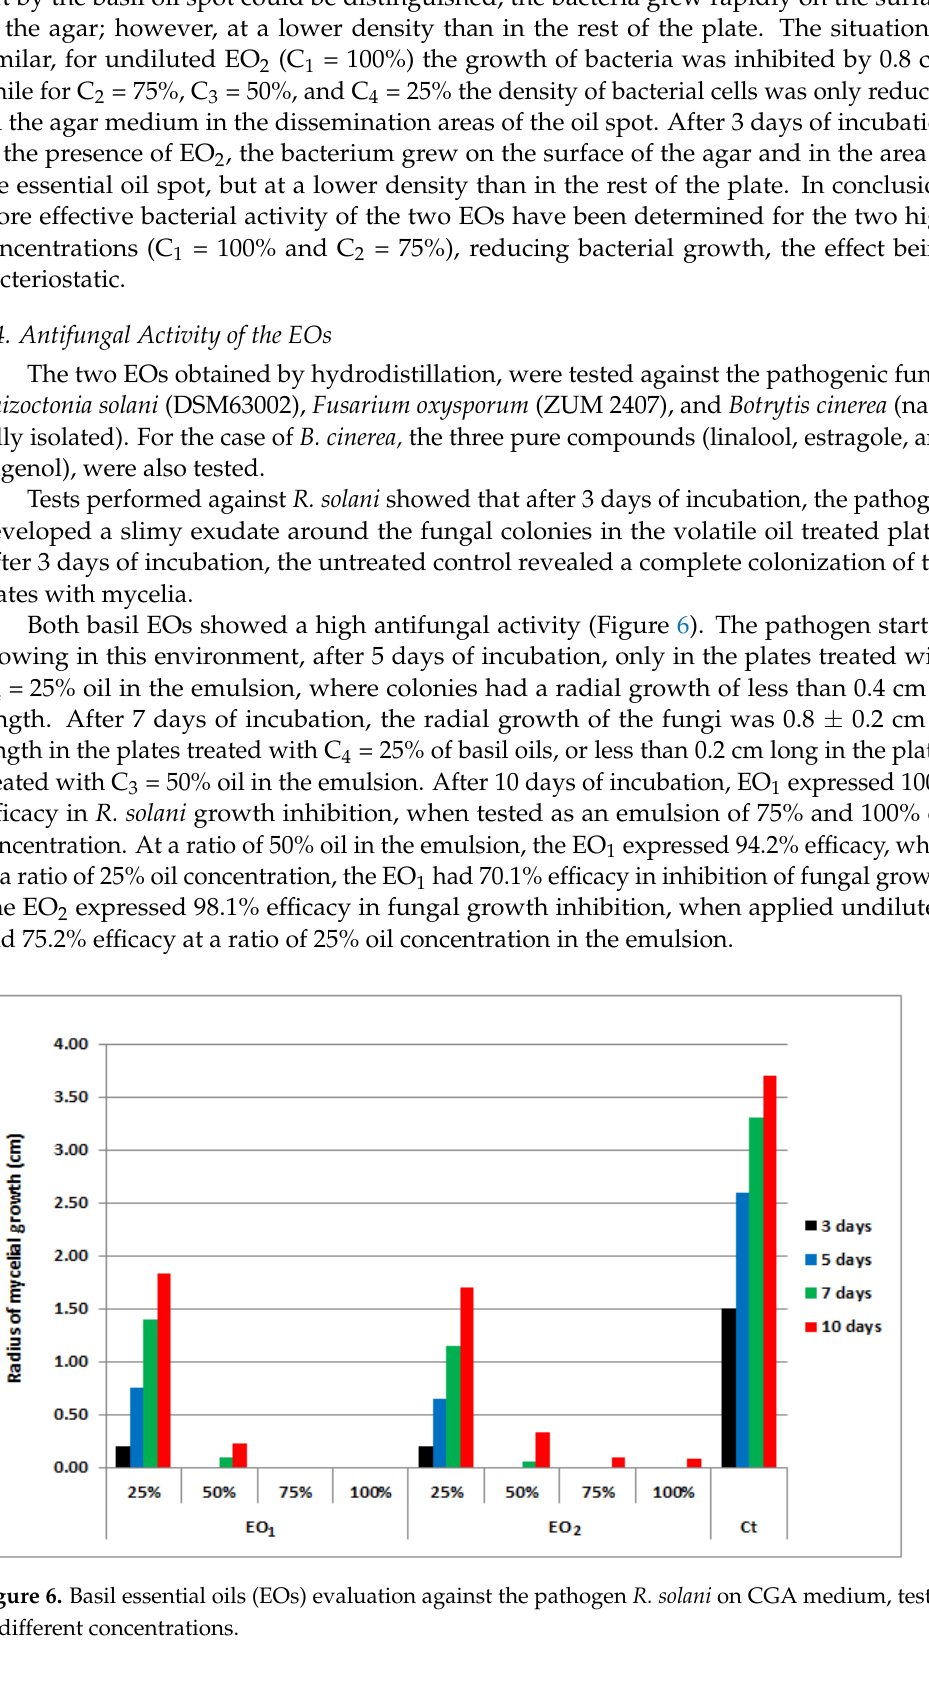
Figure 7. Microscopic aspects of R. solani cultures developed in the presence of EO 1 , C 4 = 25%; ( a ) zigzag growth of mycelial hyphae; ( b ) lysis of mycelial hyphae. Electron microscopy photos were illustrated only for the most unfavorable scenario (C 4 = 25% concentration) to emphasize the clear effect of EO 1 in breaking the pathogen cells. The tests performed against F. oxysporum (after 10 days of incubation at 27 °C), culti- vated in the presence of undiluted EO 1 and EO 2 , had mycelial growth inhibited perfor- mance by 96.7% and respectively 98.2%, compared to the untreated control. At C 2 = 75%, the two essential oils presented an inhibitory efficacy of 82.4% in the case of EO 1 and